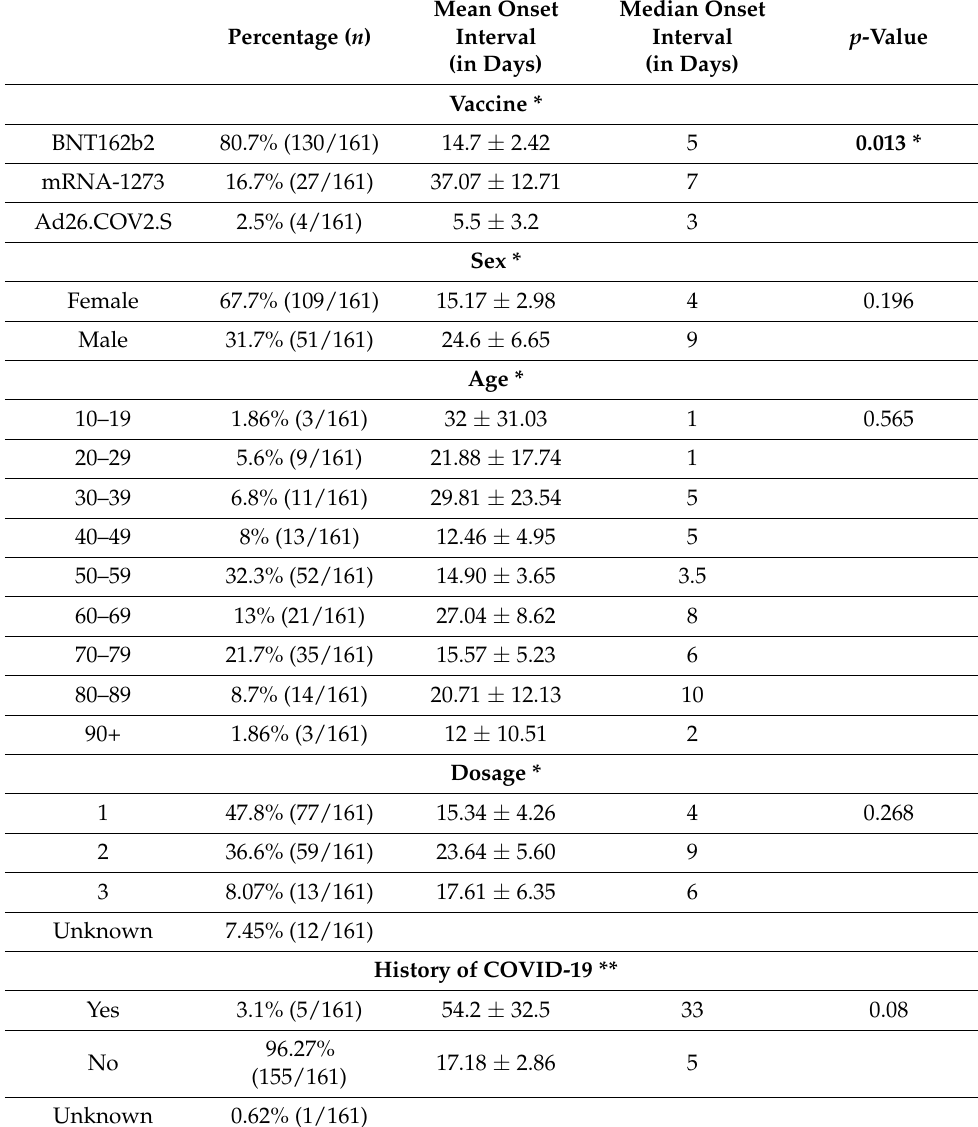
Table 4. Analysis to assess factors associated with onset interval of glaucoma following SARS-CoV-2 vaccination.